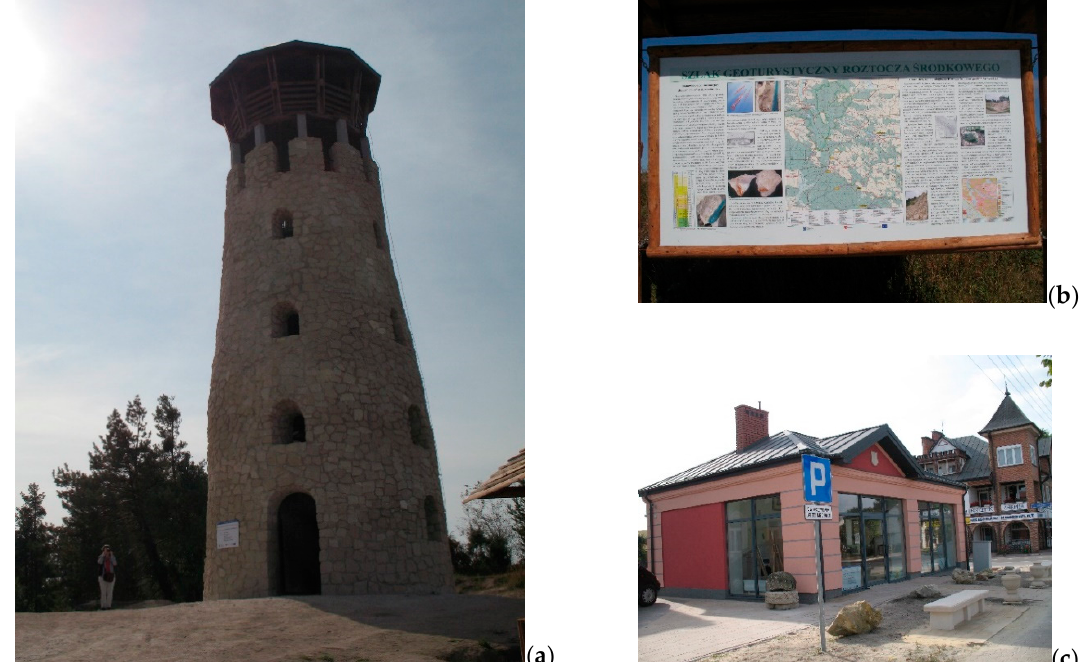
Figure 12. Some objects on the Central Roztocze Geotourism Trail : ( a ) limestone watchtower in Józefów, ( b ) one of the charts, ( c ) Geotouristic Pavilion .